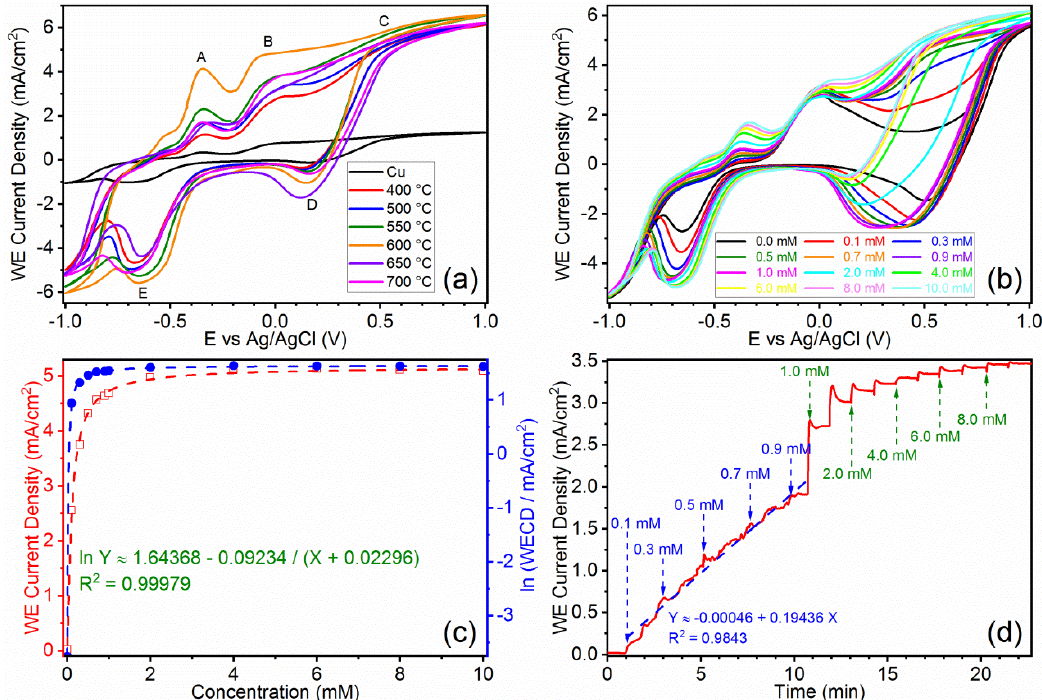
Figure 4. Electrochemistry-based glucose biosensing tests. ( a ) CV curves of samples subjected to different heat treatment temperatures (tested in 10 mM glucose). ( b , c ) Sensitivity test of CuO-600, comprising of ( b ) CV curves in various concentrations of glucose and ( c ) the corresponding trend lines. ( d ) CA curve with sequential addition of glucose under constant